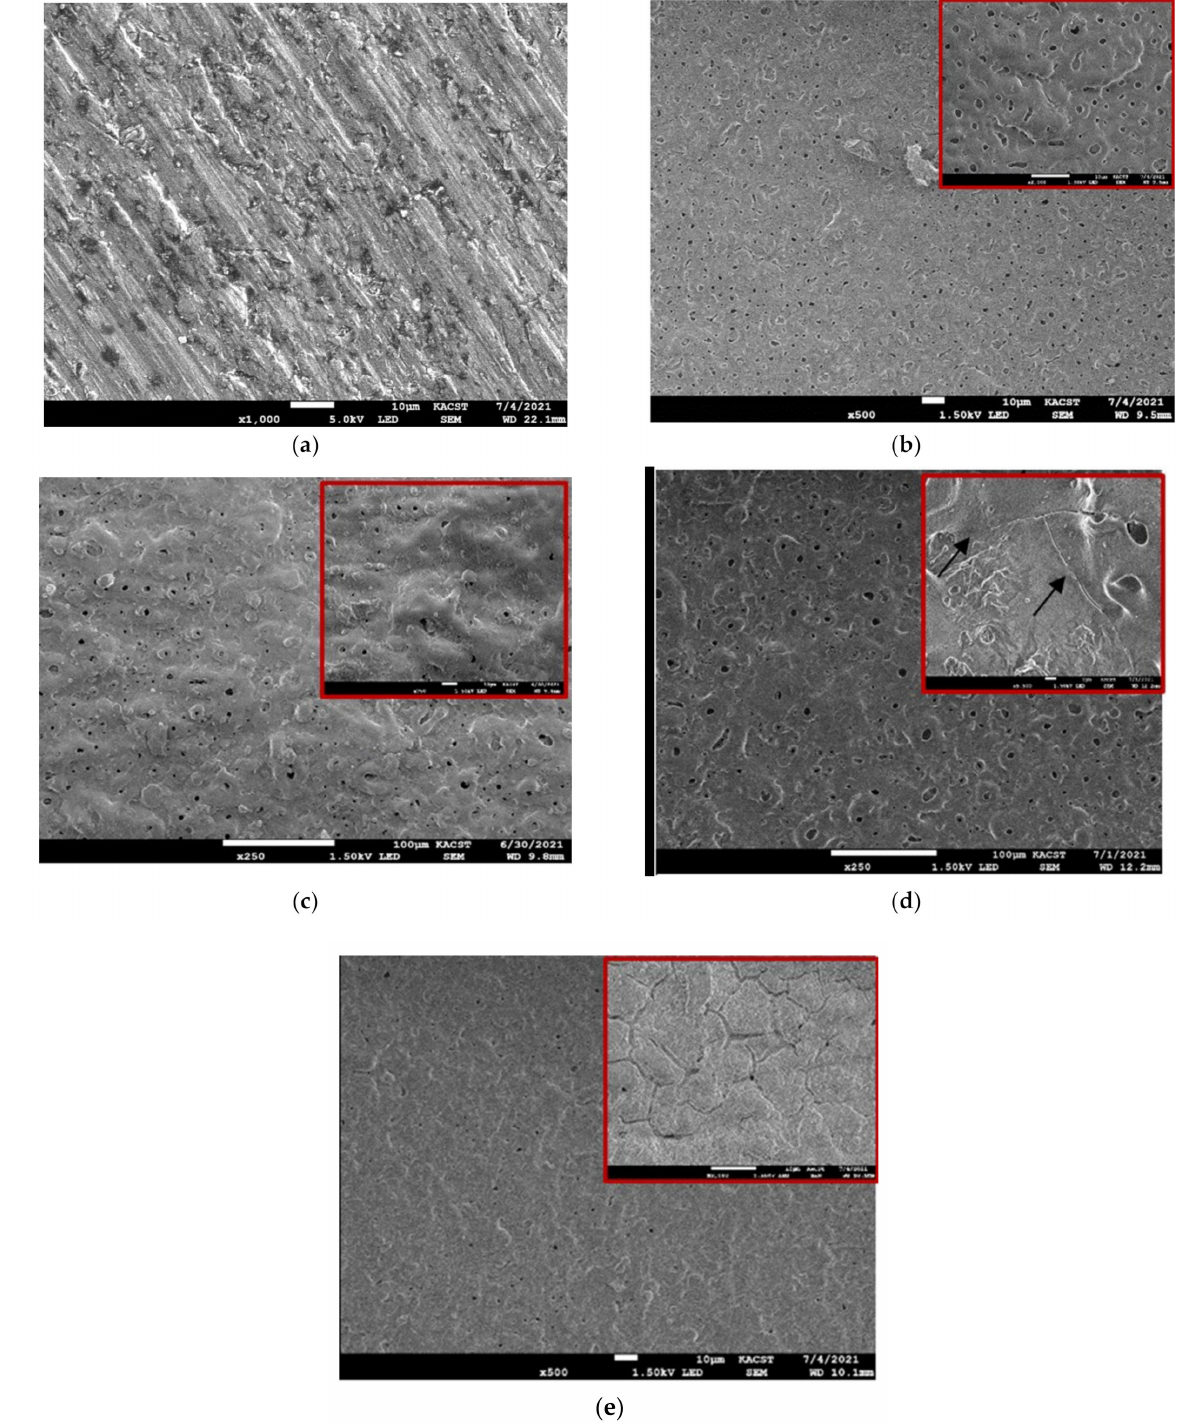
Figure 1. SEM micrographs of AA2014 Al alloy samples subjected to PEO coating under different conditions: ( a ) BM, ( b ) BP50, ( c ) SiC/UP30, ( d ) SiC/BP50_1000, and ( e )